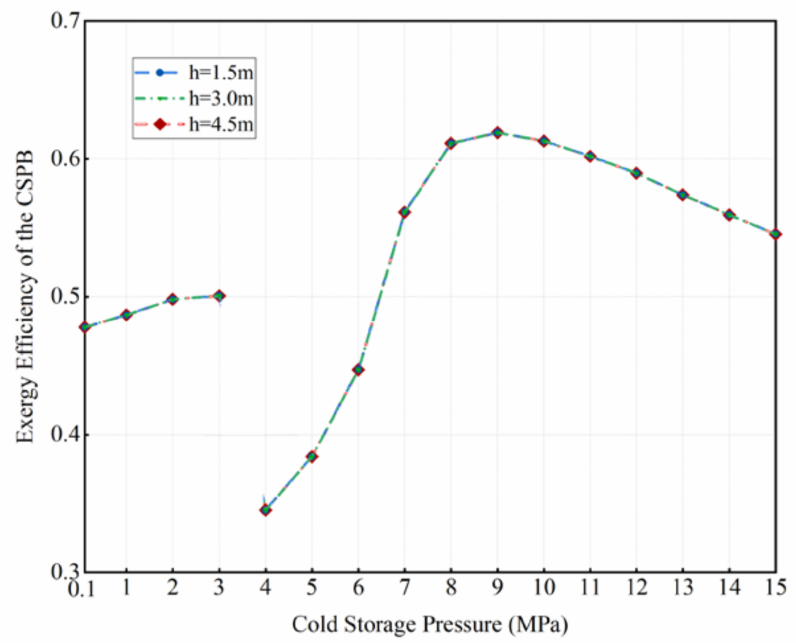
Figure 12. The effects of the cold storage pressure on the exergy efficiencies of the CSPB for different cases at the first